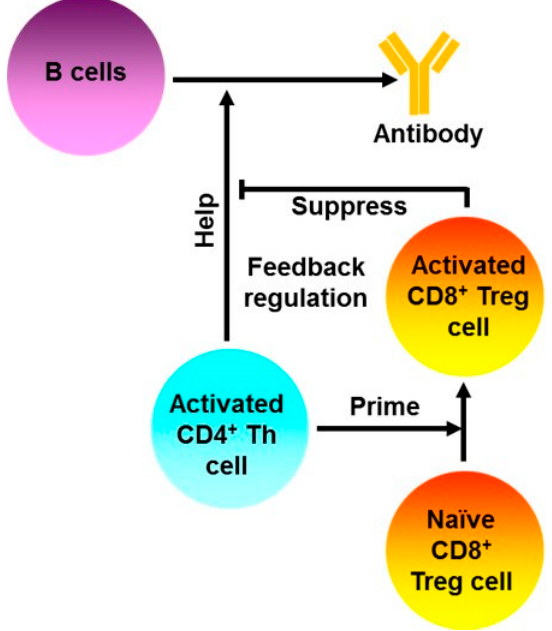
Figure 2. Activated CD4 + T cells prime CD8 + Treg cells. Activated CD4 + Th cells can activate a subset of CD8 + T cells that suppress the ability of the activated CD4 + Th cells to provide help for B cells to produce antibodies, a process called feedback regulation. Color codes are used for distinguishing different types of cells and molecules only.